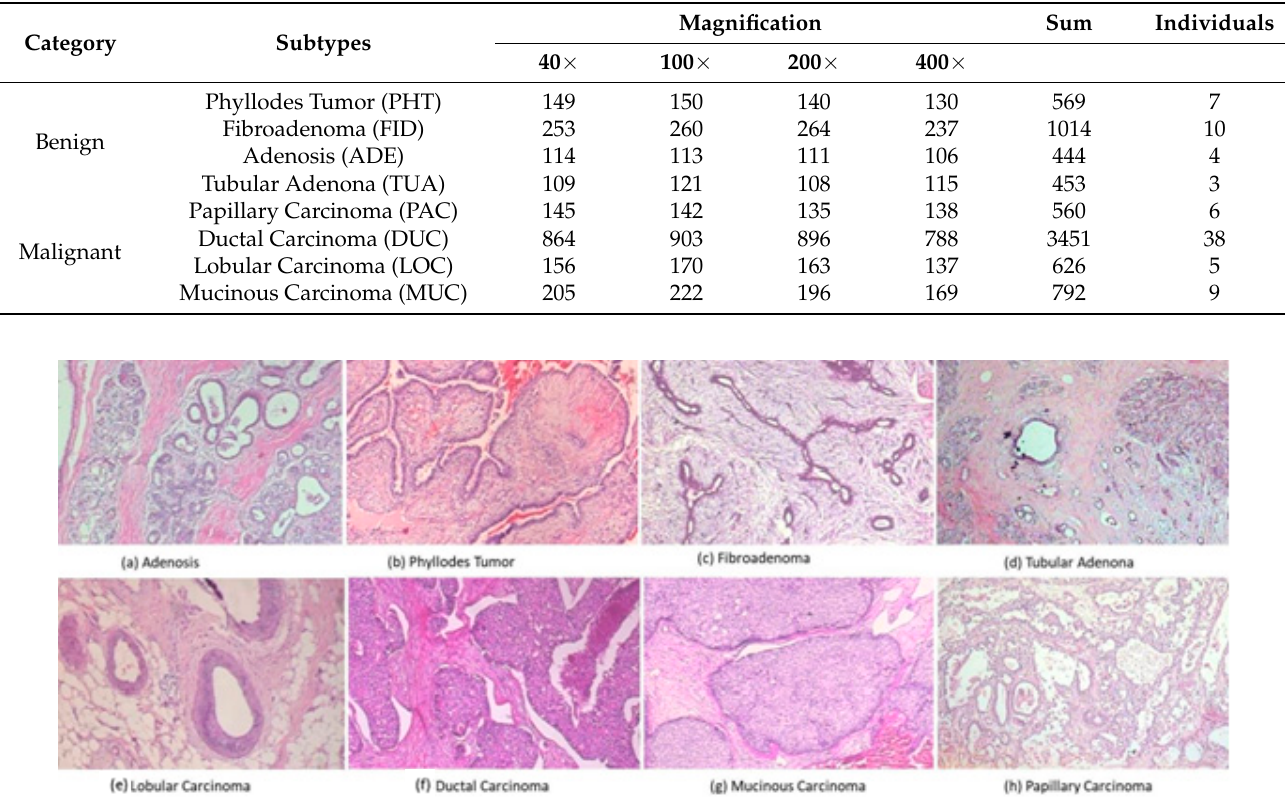
Table 2. BreakHis dataset categorization at patient level at four magnifications (40×, 100×, 200×, and 400×).